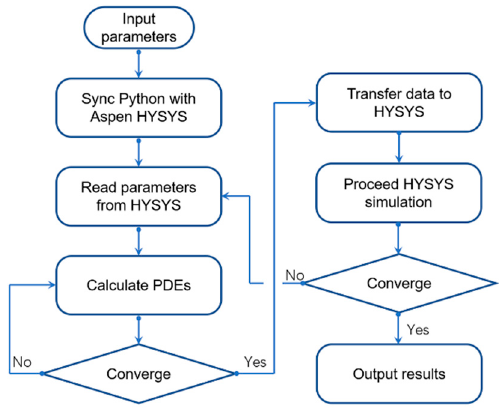
Figure 3. Schematics of simulation procedure of the proposed model.